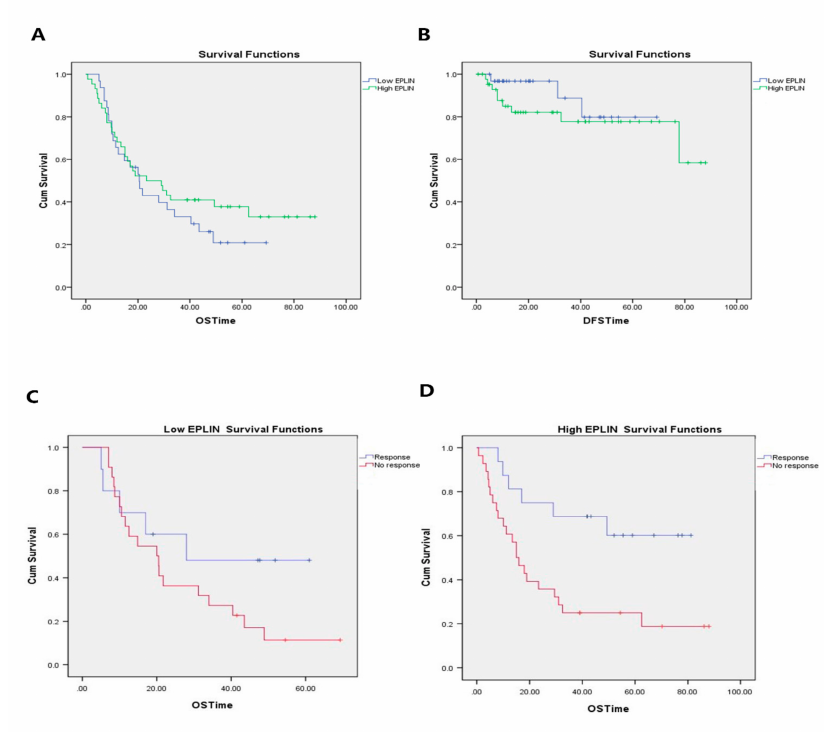
Figure 5. Relationship between EPLIN transcript expression and prognosis in patients with NAC and chemoresistance. ( A ): Patients with NAC expressing higher EPLIN levels seemed to have a slightly longer OS than those expressing lower EPLIN levels. ( B ): Patients with low EPLIN expression had better rates of disease-free survival in the early time period than those with high EPLIN expression, but in the later time period the rates of disease free in both groups were similar. ( C ): In patients with low EPLIN expression, the overall survival distribution was undertaken based on the different levels of responsiveness to NAC. ( D ): In patients with high EPLIN expression, the overall survival distribution was conducted for the different levels of tumour response to